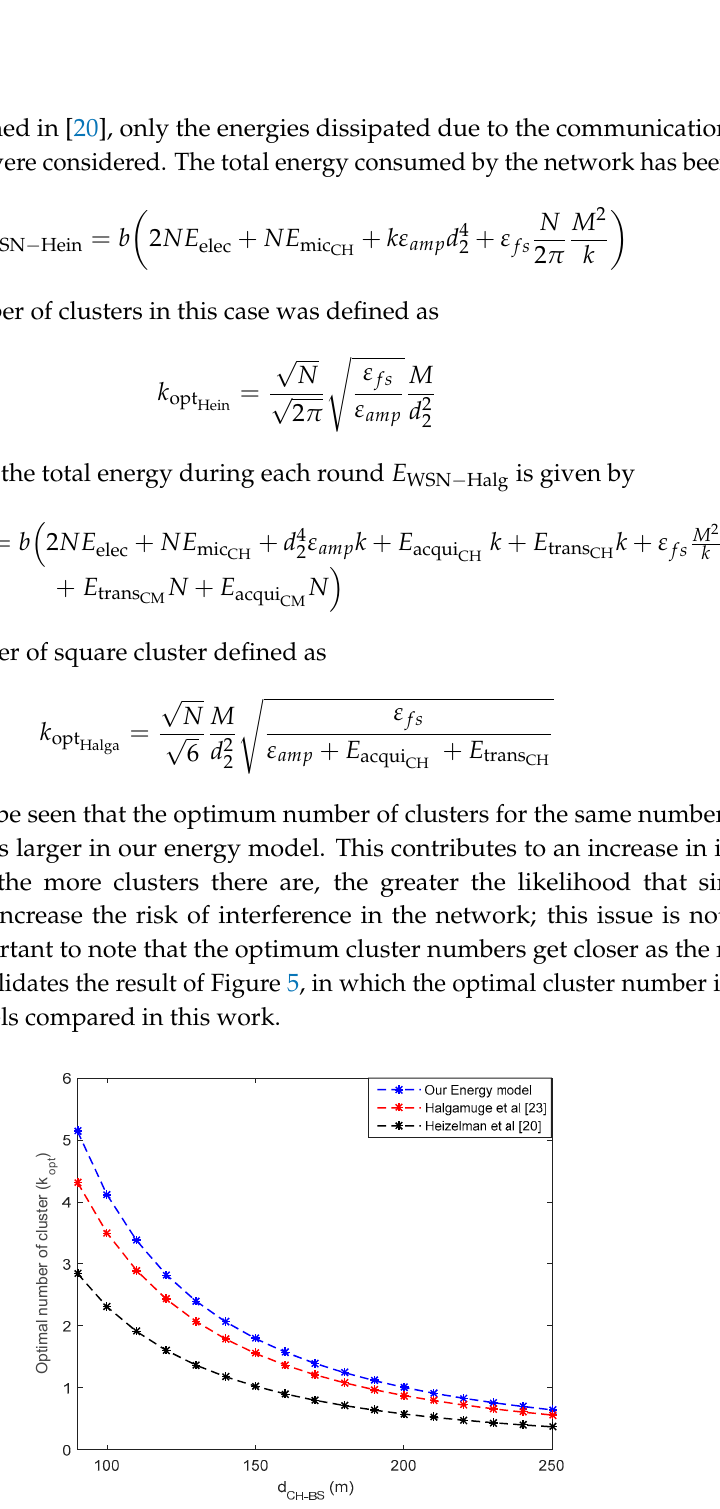
Figure 6. Optimal number versus distance from CH to BS.